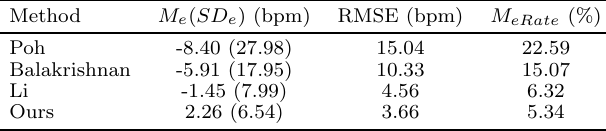
Table 1: Mean and standard deviation of x and y error and displacement from ground truth for fixation estimation examples in Fig. 3.